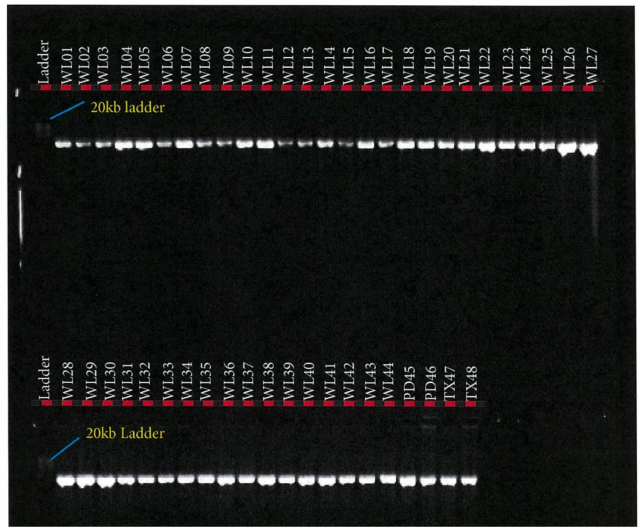
Figure 3. FASN fragment 2 PCR product in Tattykeel Australian White (WL), Poll Dorset (PD), and Texel (TX)